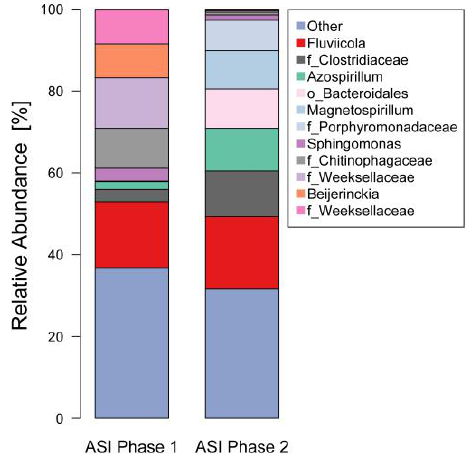
Figure 6. Genus relative abundance in the bioreactor ASI at the end of Phase 1 and 2 (most representative < 1%).